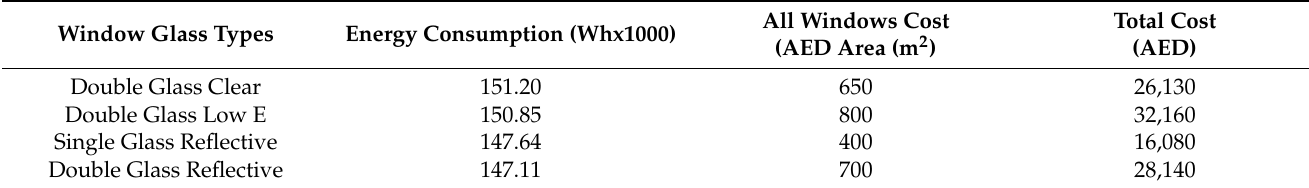
Table 7. Window glass types cost.